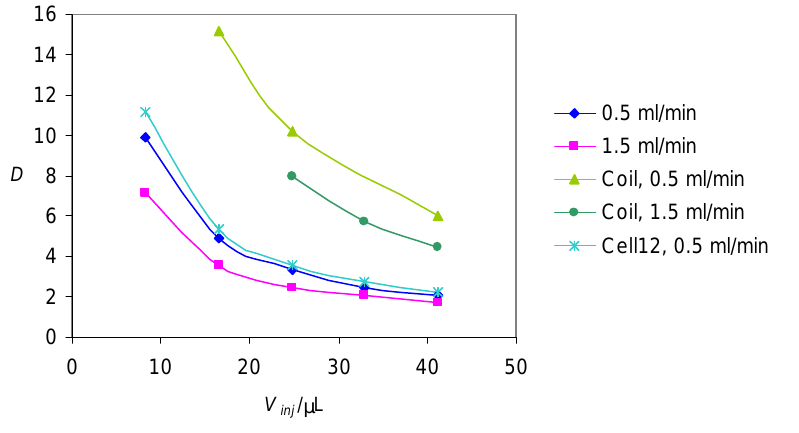
Figure 5. Dispersion coefficients obtained for different dye-injection volumes at main-stream flow rates of 1.5 and 0.5 ml/min in the range of the red light. The experiments were performed with the 10a spectrometric glass coil-type flow-through cell and no mixing coil, if not stated differently.